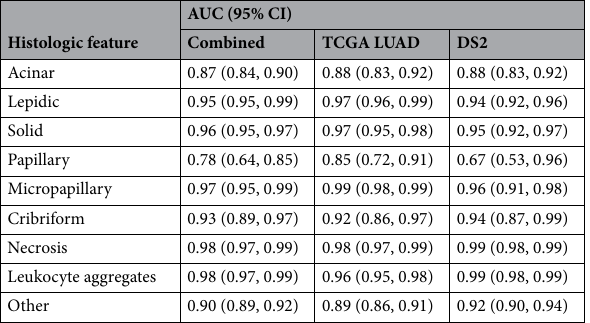
Table 2. LungCNN-Histo performance. The area under the receiver operating characteristic curve (AUC) for the 9 patterns predicted by LungCNN-Histo at the